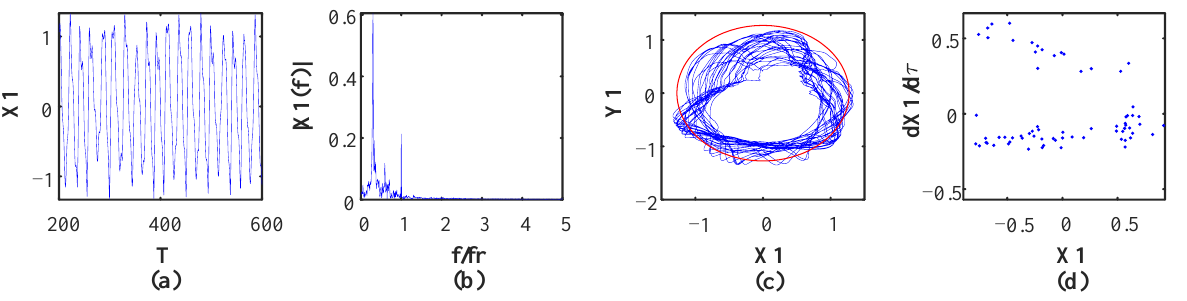
Figure 13. Numerical integration results at ω = 1662 rad/s: ( a ) Time domain waveform; ( b ) Frequency spectrum; ( c ) Shaft orbit; ( d ) Poincaré map.